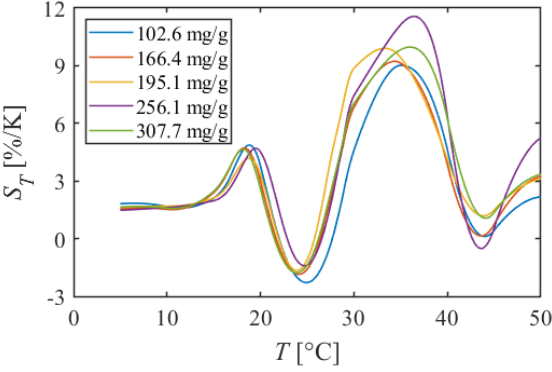
Figure 7. Temperature sensitivities of PMMA + EtOH + Toluene in different dye concentrations.